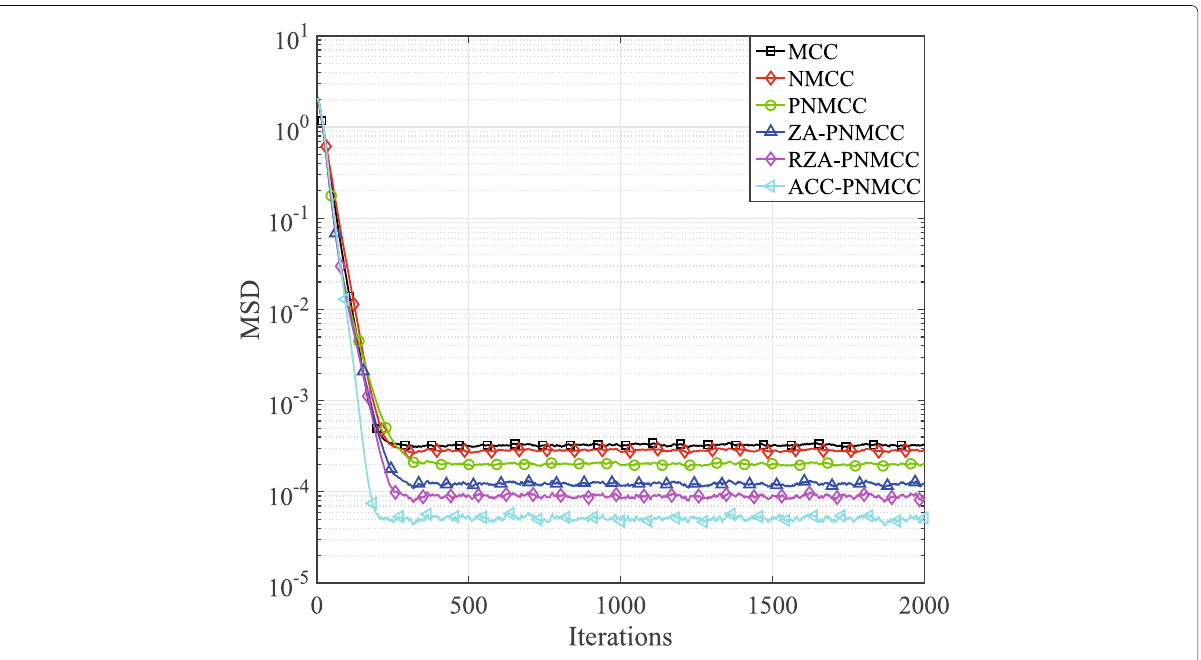
Fig. 5 The MSD performance of the proposed ACC-PNMCC algorithm with K = 2 where θ > 0 is a very small positive constant, ξ is the reweighting factor, and α ACC denotes the step size.